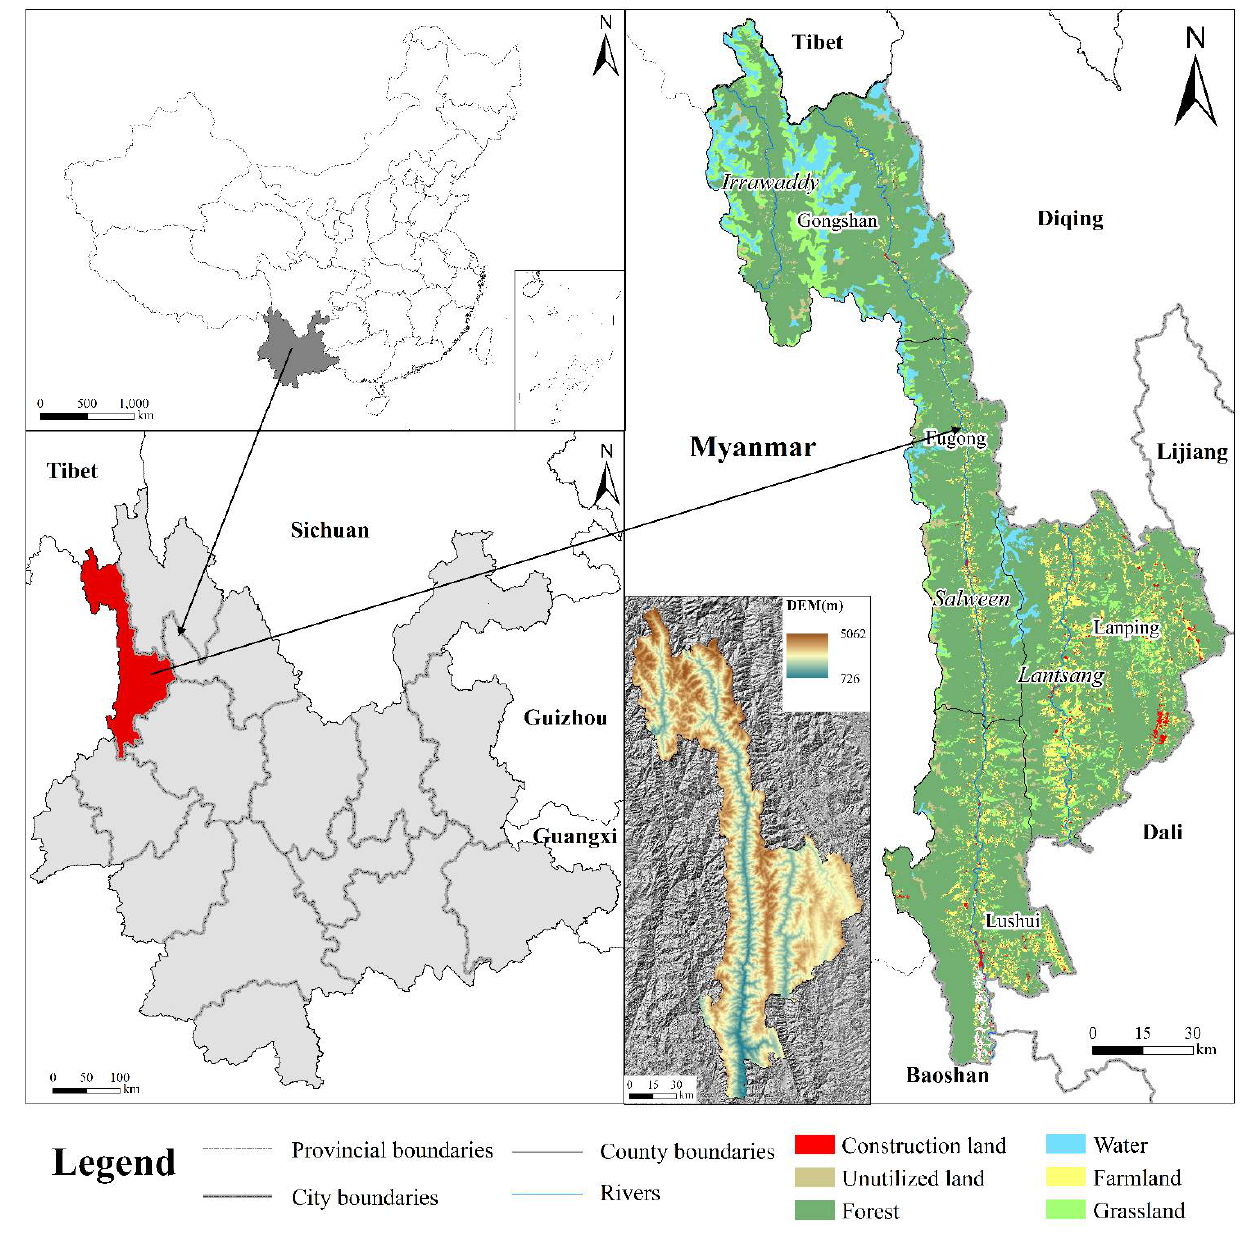
Figure 1. Location map of the study area .